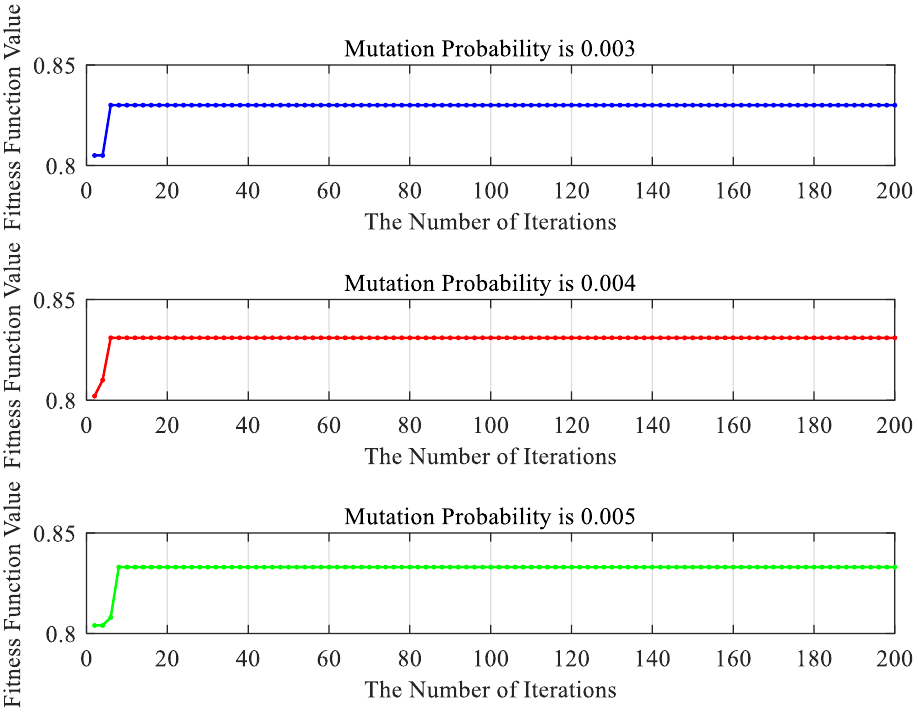
Figure 15. Influence of mutation operator on GA.